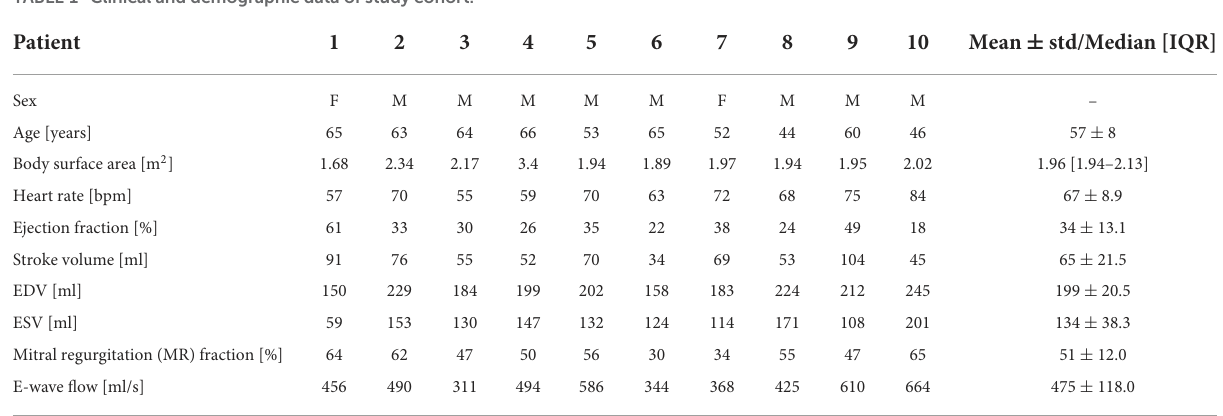
TABLE 1 Clinical and demographic data of study